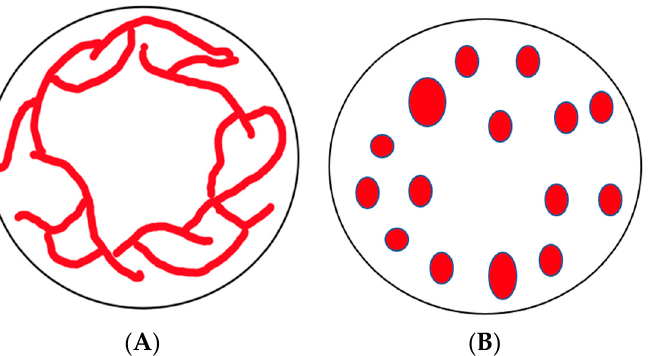
Figure 1. Drawing of mitochondrial networks seen in different types of cells. ( A ) The dynamic reticular network of tubular mitochondria seen in most yeast (budding and fission) and mammalian cells. ( B ) Network of individual mitochondria seen in some organisms, such as D. discoideum.